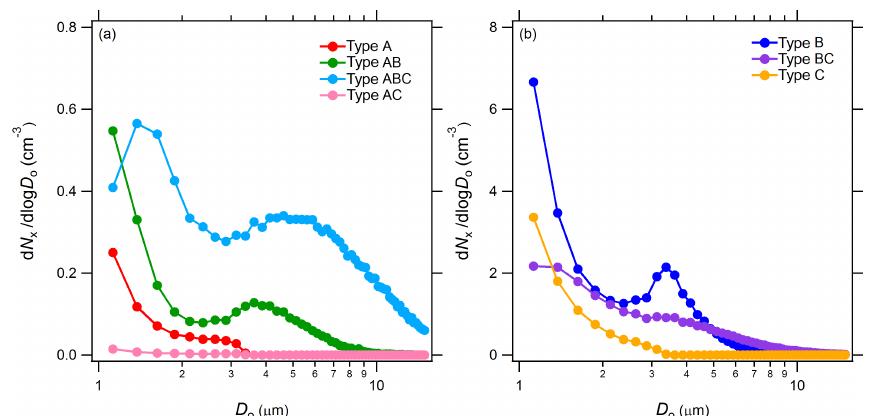
Figure 6. Mean number size distributions of (a) type A (red), type AB (green), type AC (pink), and type ABC (light blue); (b) type B (blue), type BC (purple), and type C (dark